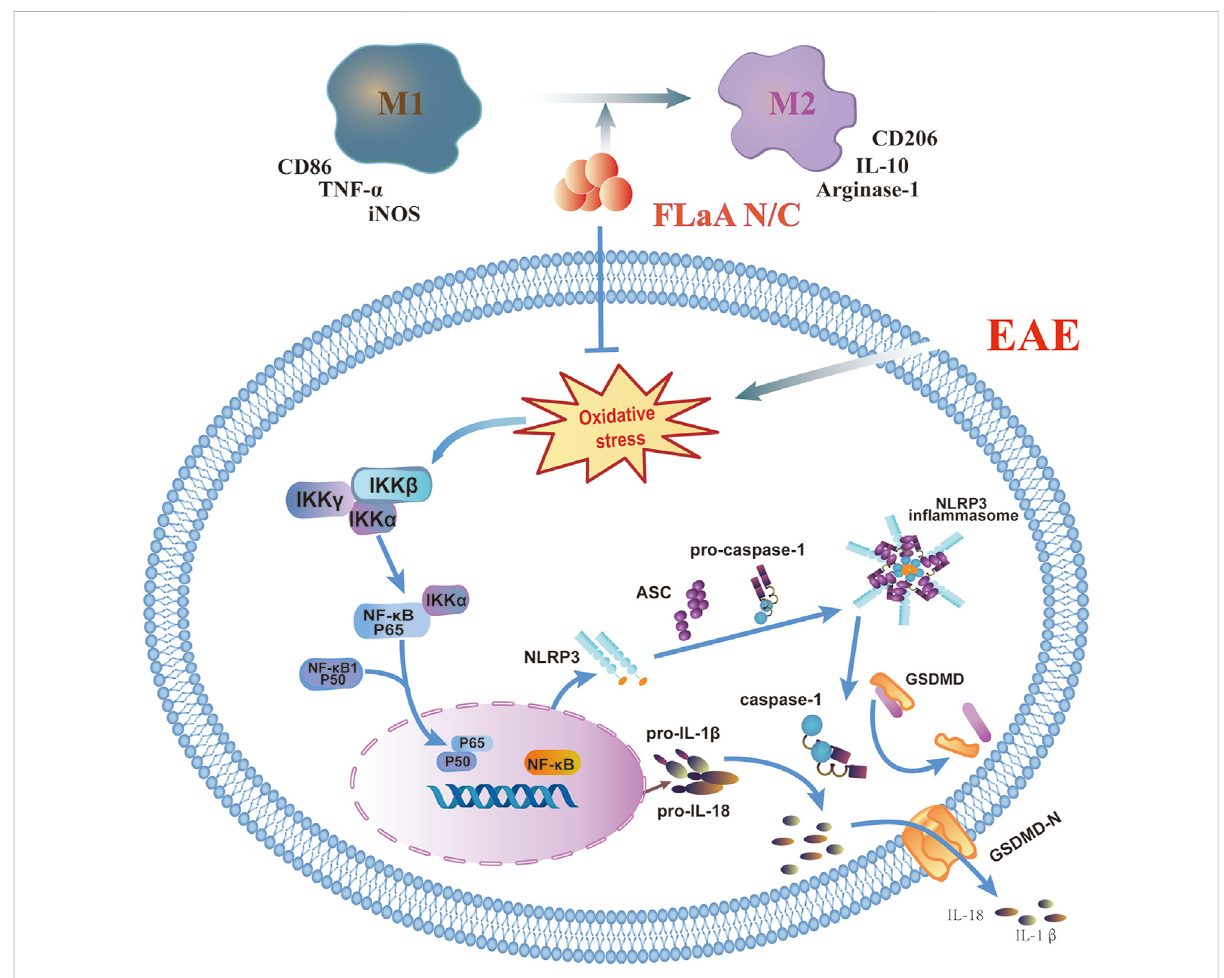
FIGURE 8 FLaAN/C attenuated in fl ammatory response by facilitating macrophages/microglia polarization from the M1 phenotype to the M2 phenotype and inhibiting the ROS/NF- κ B/NLRP3 signaling pathway, and thus alleviated